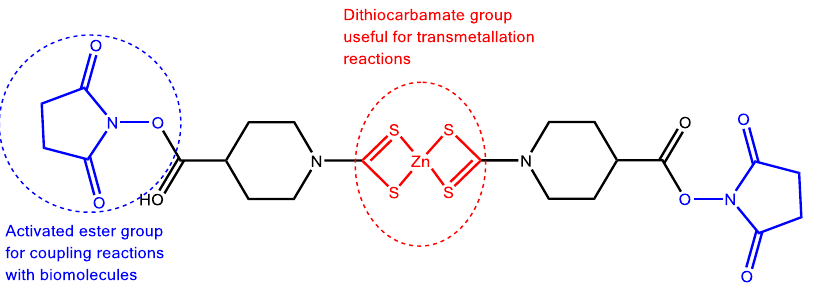
Figure 1. Molecular structure of 1 Zn .